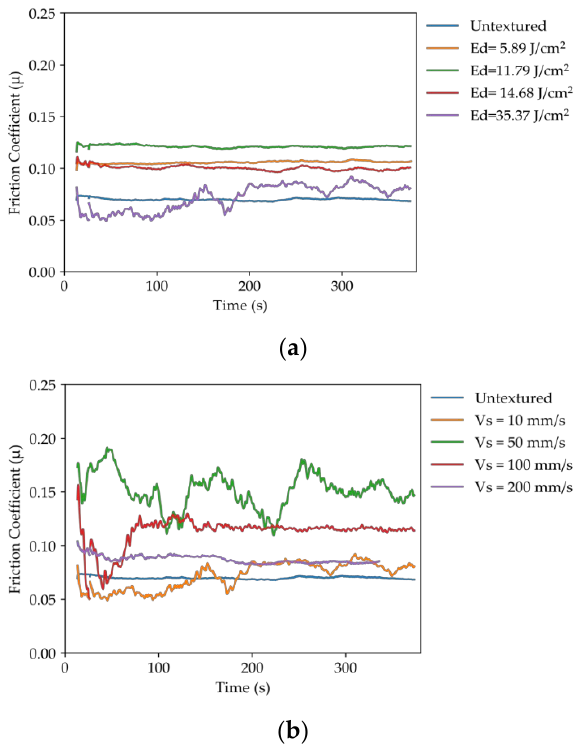
Figure 8. Friction coefficient as a function of ( a ) Ed (10 mm/s); ( b ) Vs (35.37 J/cm 2 ).